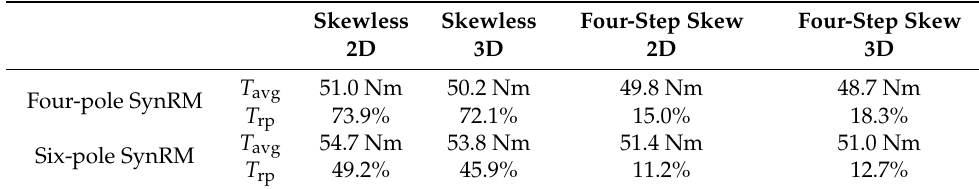
Table 8. Average torque and torque ripple comparison when applying four-step skewing, by means of 2D and 3D FEA